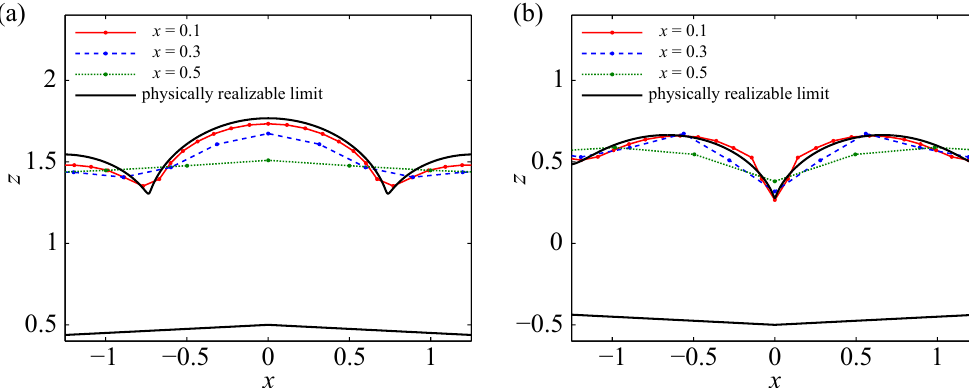
Figure 8. Cathode shapes in the vicinity of a sharp corner of a convex (Panel ( a ), A = 5 in Equation (30)) or concave (Panel ( b ), A = − 5 in Equation (30)) anode. Spatial dimensions are normalized to the width of the standard equilibrium front gap. The quantity ∆ x denotes the mesh cell size in x direction used in the computation. The circles on the lines mark the positions of the mesh vertices. The upper solid line illustrates the limit of the physically realizable shape of the